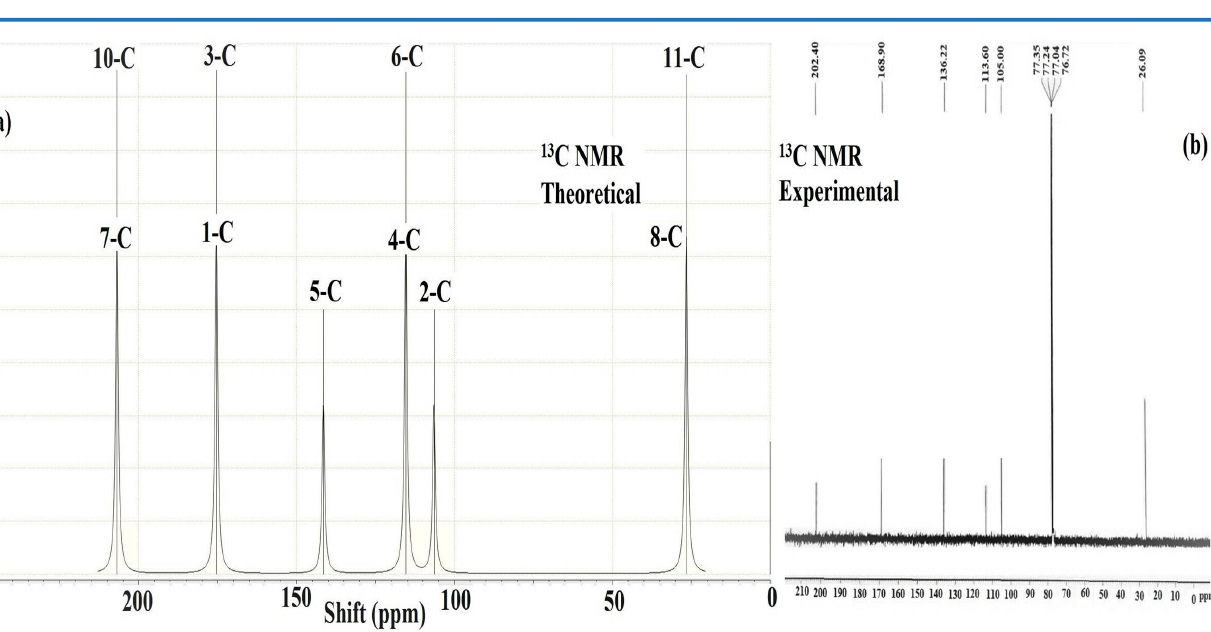
Figure 10. Calculated ( a ) and experimental ( b ) 13 C-NMR spectra of the isolated compound 1.